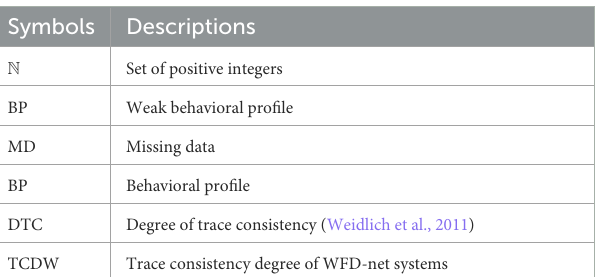
TABLE 1 Common symbols used in this